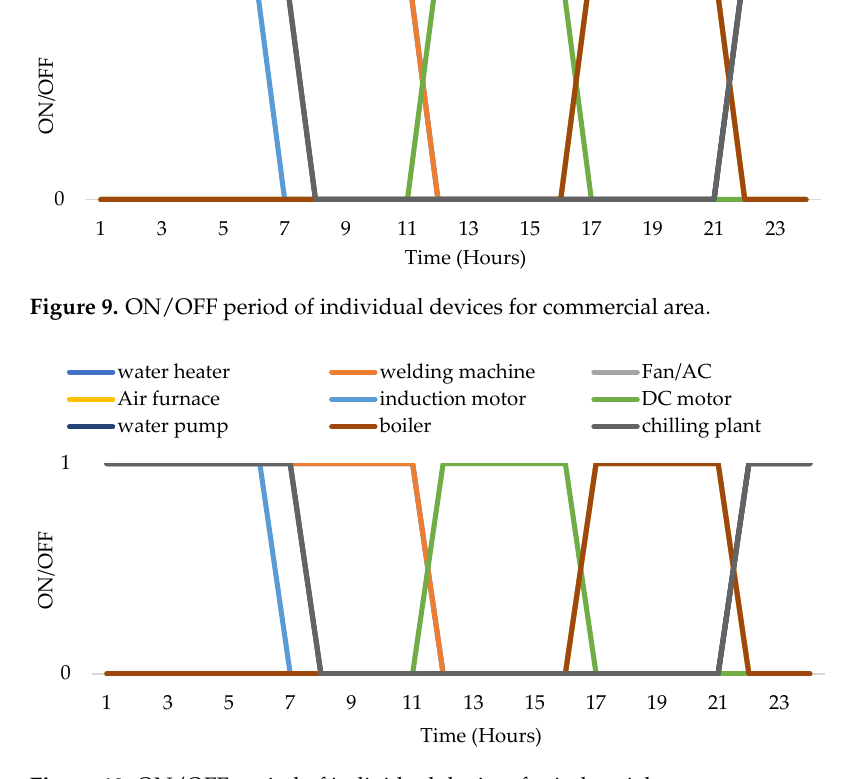
Figure 10. ON/OFF period of individual devices for industrial area. The different load curves of the forecasted objective and load that shifted after DSM with peak load reduction are shown in Figures 11–13. In the residential area, the peak load